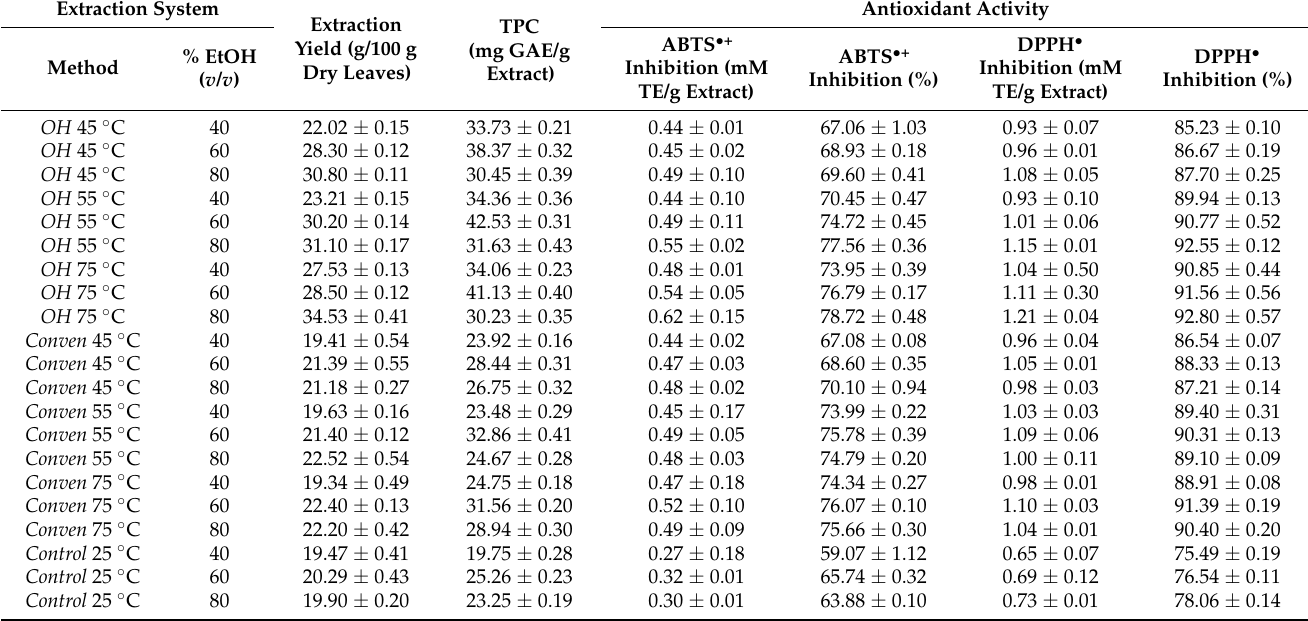
Table 2. Mean values ( ± SD) of yield and functional properties of extracted olive mill leaves – extraction yield (g/100g dry leaves), total phenolic content (mg GAE/g extract), TEAC assays (ABTS and DPPH radical scavenging activity mM TE/g extract), and % inhibition of DPPH and ABTS